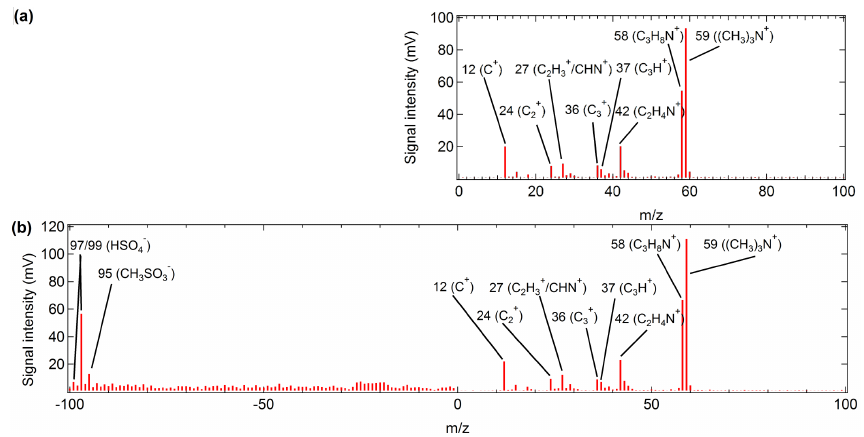
Figure 13. Mean spectra of the “Non-K,NH 4 -containing” TMA particle sub-type: (a) single-polarity particle mass spectrum (12%, yellow box in Fig. 9), (b) dual-polarity particle mass spectrum (6%, not colored in Fig. 9).